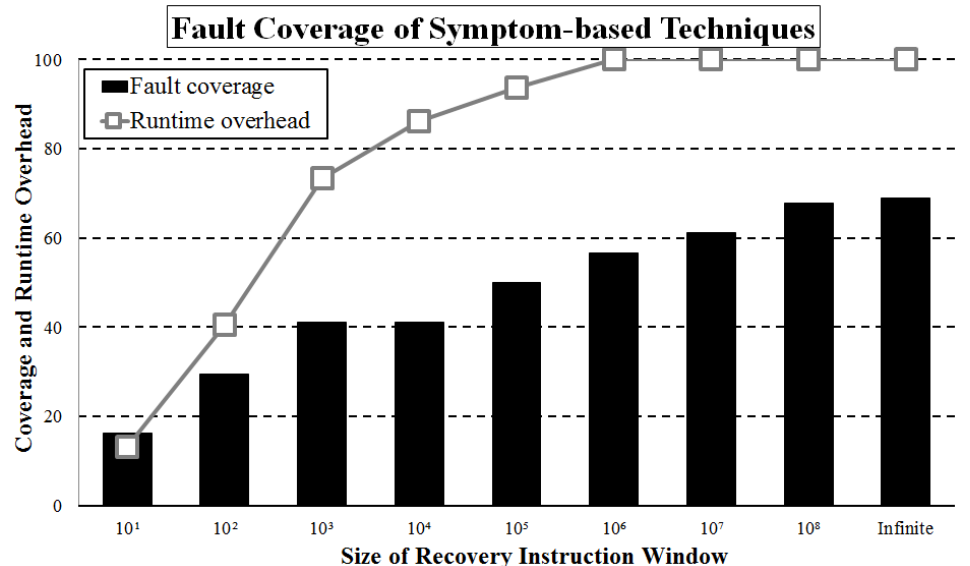
Figure 8. We can cover more SOCs by re-executing more instructions when symptoms are detected. However, the runtime overhead exceeds the fault coverage if we use a large recovery instruction